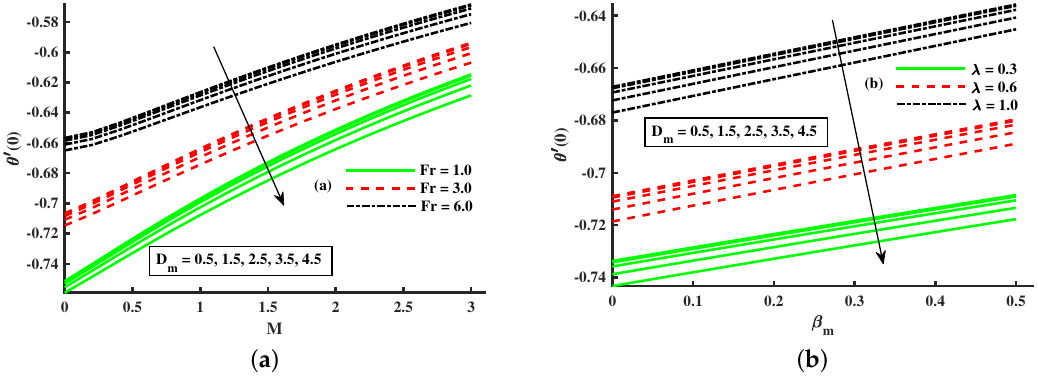
Figure 21. Effect of Fr , D m , M on Nusselt number ( a ) effect of λ , D m , β m on Nusselt number ( b